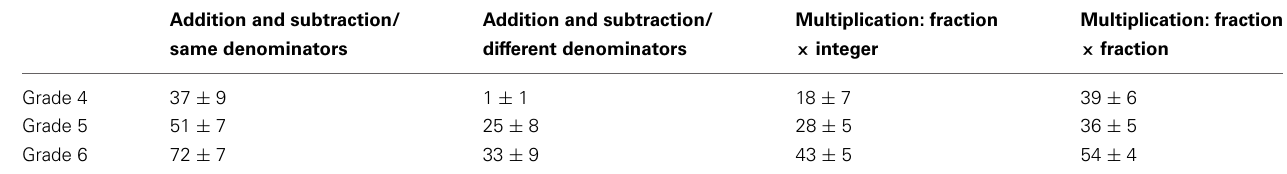
Table 5 | Mean percentage of correct responses and standard deviation for each type of operations in Grade